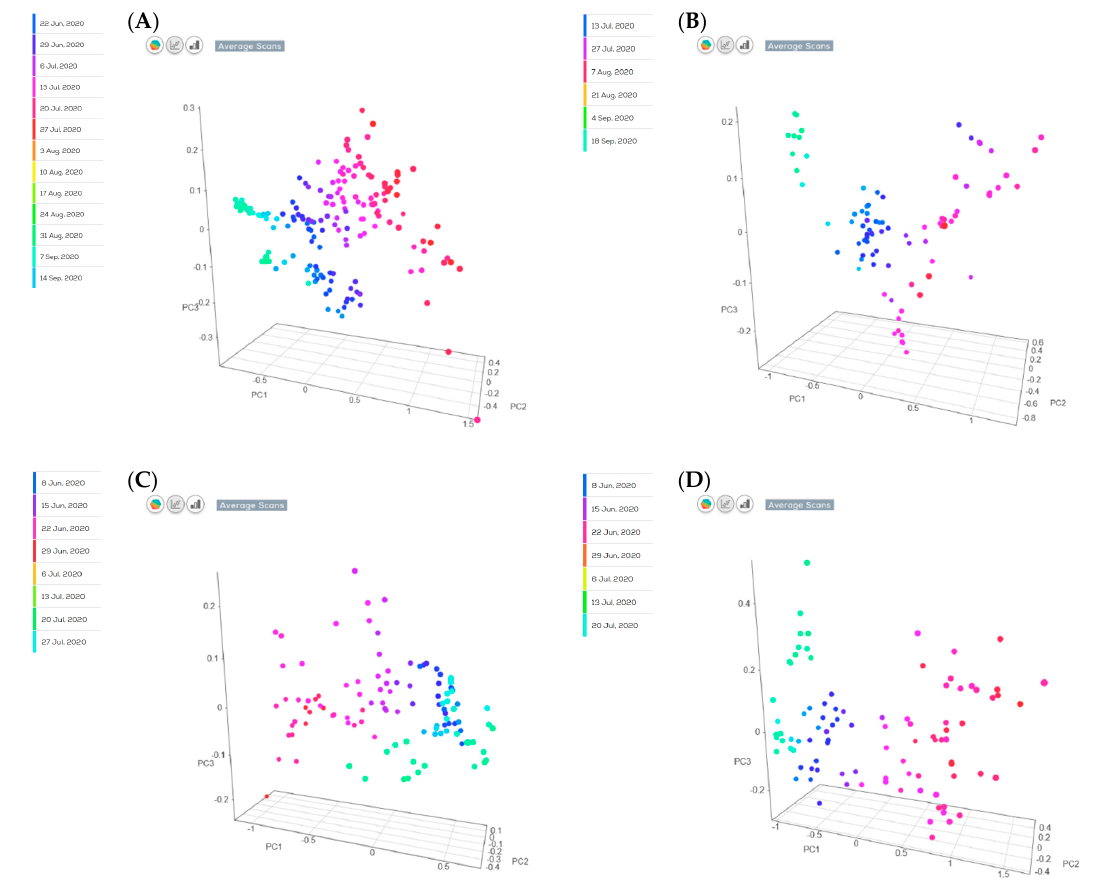
Figure 4. PCA after the pre-treatments for Allison™ ( A ), Autumncrisp ® ( B ), Cotton Candy™ ( C ) and Summer Royal ( D ). The different colors indicate the various sampling times for each cultivar as shown in the legends.